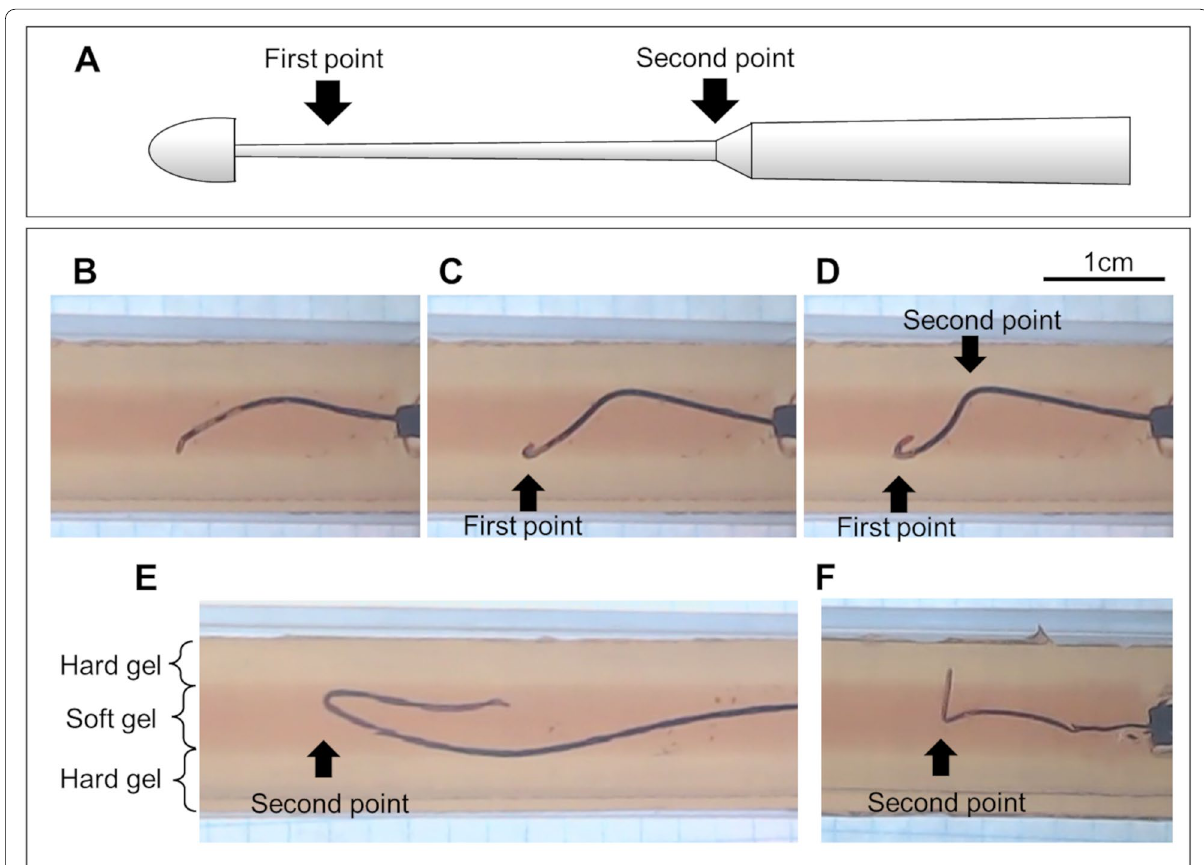
Fig. 1 Scheme of the round core and pictures in the CTO model of Gladius MG ™ . a Because the tip of the round core is narrowing, the Gladius MG ™ has two bending points. (B-E) A 0.018-inch Gladius MG ™ was inserted into the soft gel of the CTO model. b The tip of the Gladius MG ™ was attached to the hard gel. c The Gladius MG ™ was pushed further after the tip was attached to the hard gel; the first point was bending. d The Gladius MG ™ was pushed further after being bent the first point, the second point began to bend. e When the Gladius MG ™ was pushed more after bending at the second point, the Gladius MG ™ was advanced into the soft gel with a looped shape. The bending point of the looped shape Gladius MG ™ was the second point. f When the tip and the first point of the 0.014-inch Gladius MG ™ advanced into the hard gel, on pushing the wire further, the second point began to